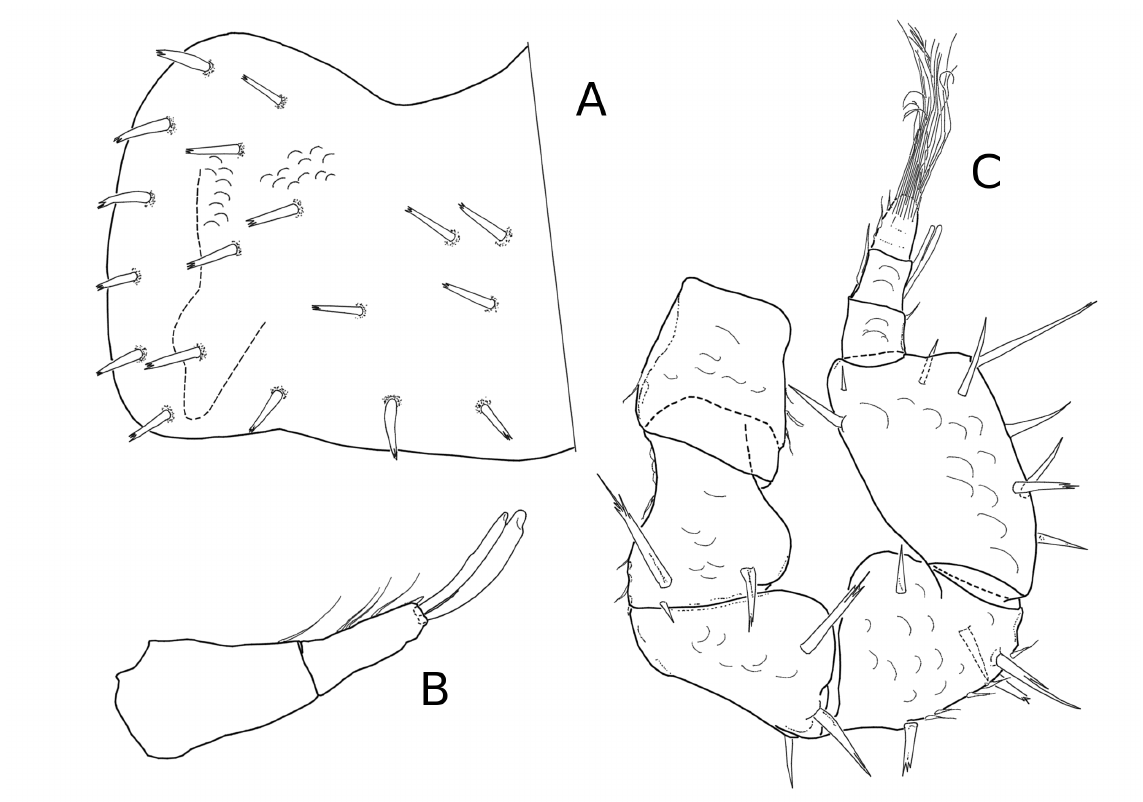
Fig. 4. Buchnerillo atlanticus sp. nov., paratype, ♂ (MBCN 24683). A . Left half of pereon-tergite 1, extended; the interrupted lines represent the ventral lobe. B . First antenna. C . Second antenna. Figure not to